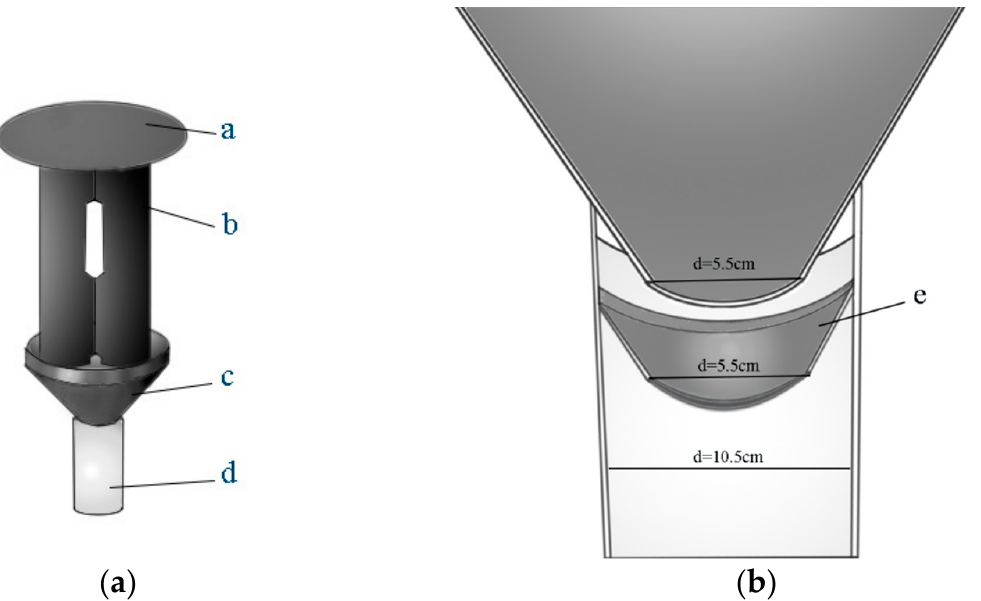
Figure 1. ( a ) The black cross-vane trap; ( b ) trap funnel and collection cup section. a: circular top; b: cross-shaped panel; c: funnel; d: collection cup; e: anti-escape ring.